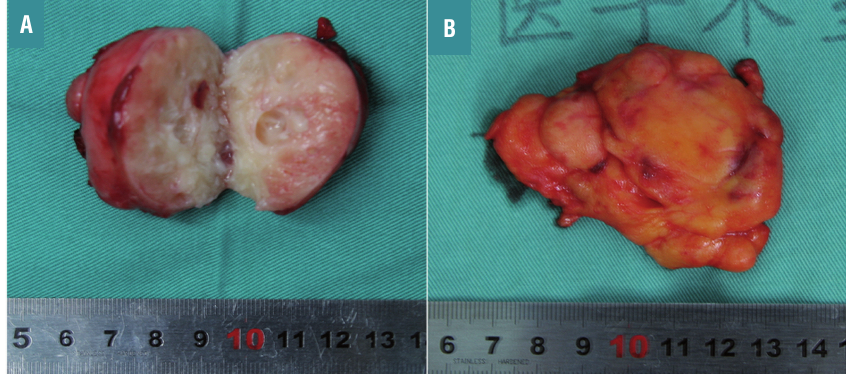
figure 2 - Gross pathologic features of the resected specimen. The cut section indicated a red-white cystic solid tumor mass measuring 5×4cm (A). The lesion was completely resected and accompanied with some fat covering the outer surface (B).